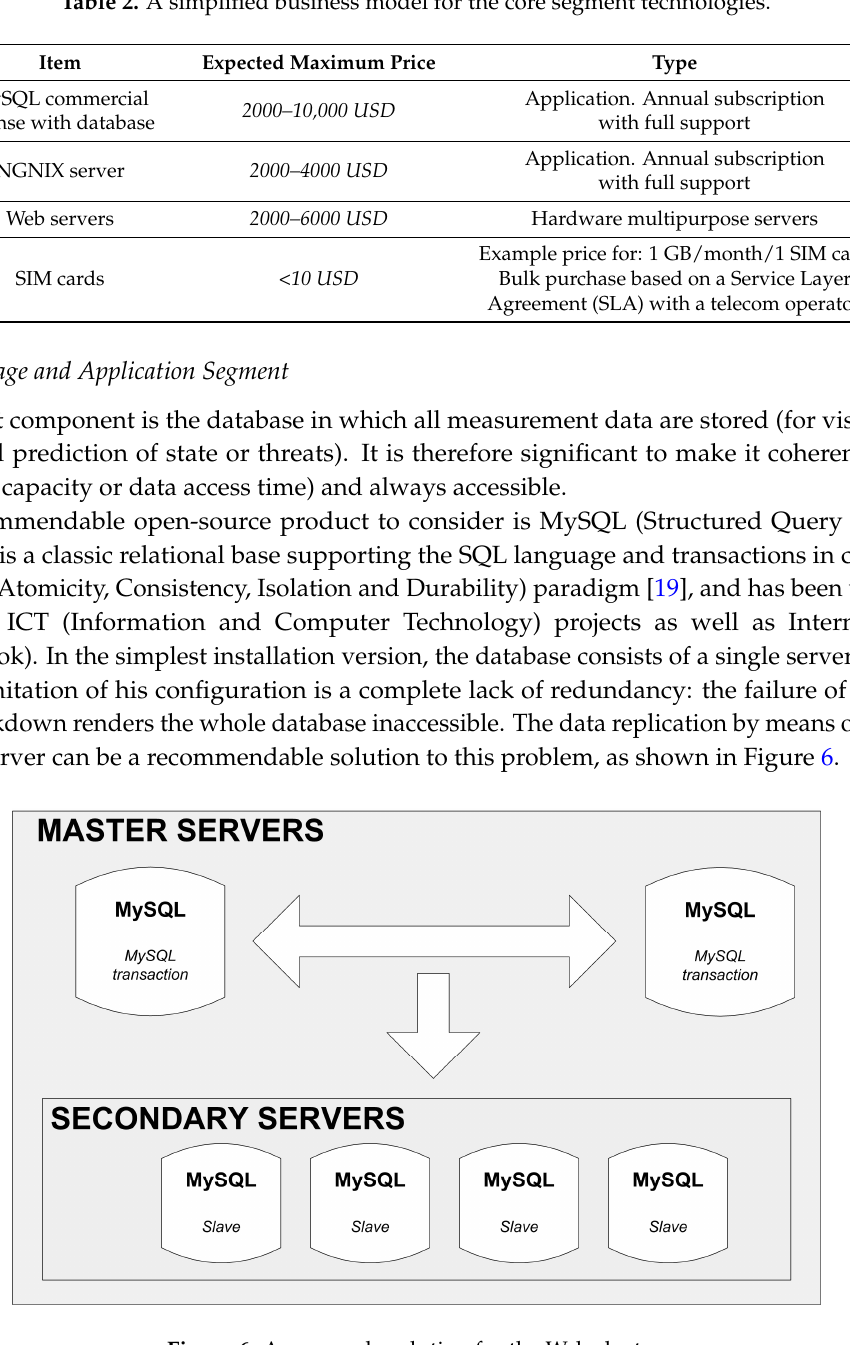
Table 2. A simplified business model for the core segment technologies.